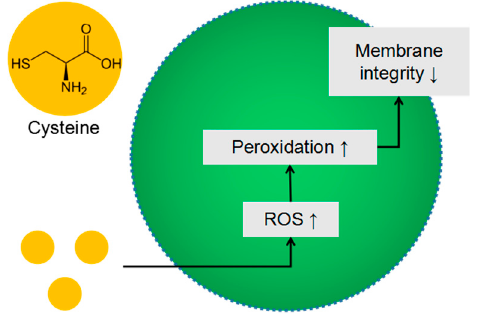
Figure 8. Schematic model of zwitterionic cysteine drug in antibacterial action.